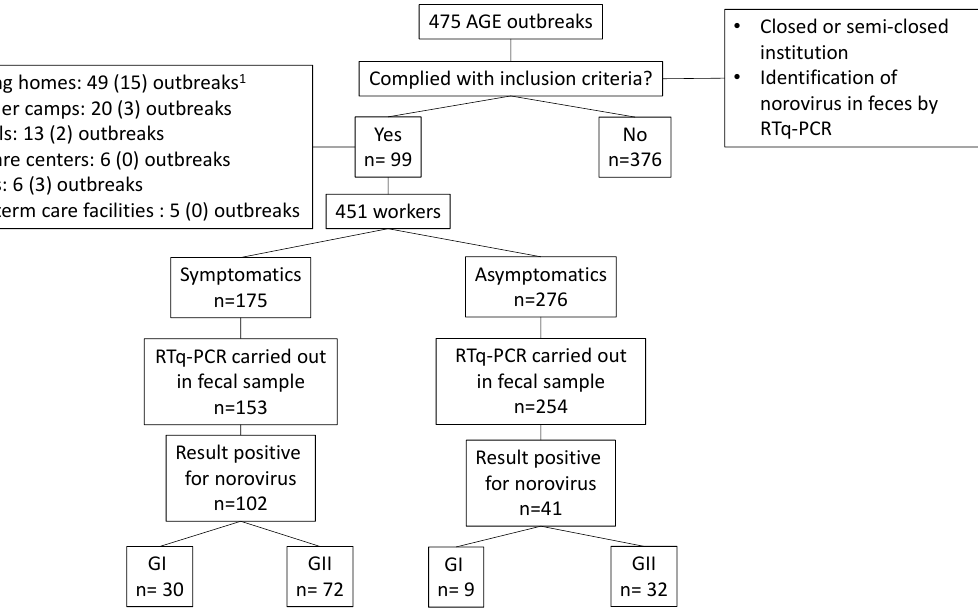
Figure 1. Study flowchart. 1 In brackets, the number of outbreaks in which the first case was a worker. In 74 outbreaks (74.8%), transmission was person-to-person; in the remaining 25 (25.2%), it was due to a common vehicle.